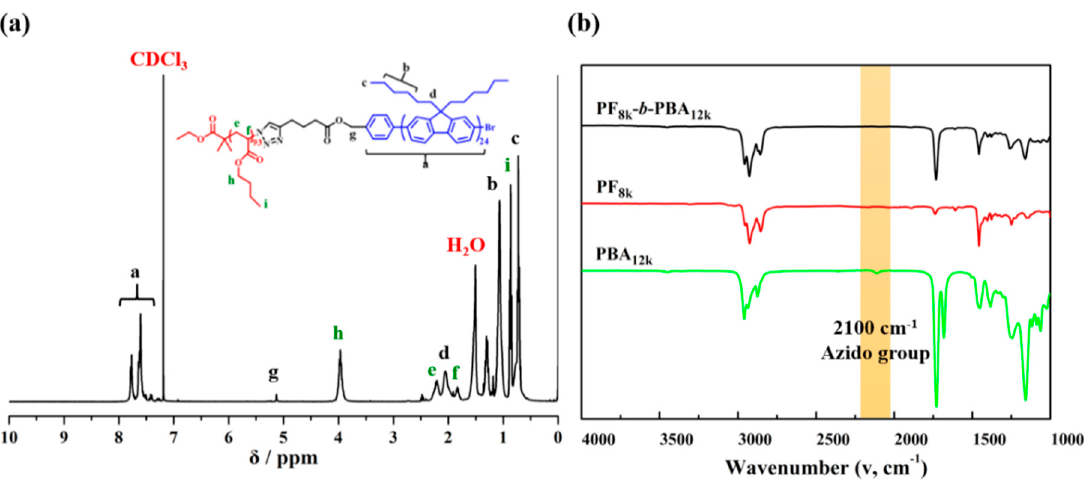
Scheme 1. Synthetic route for PF- b -PBA rod-coil block copolymer.